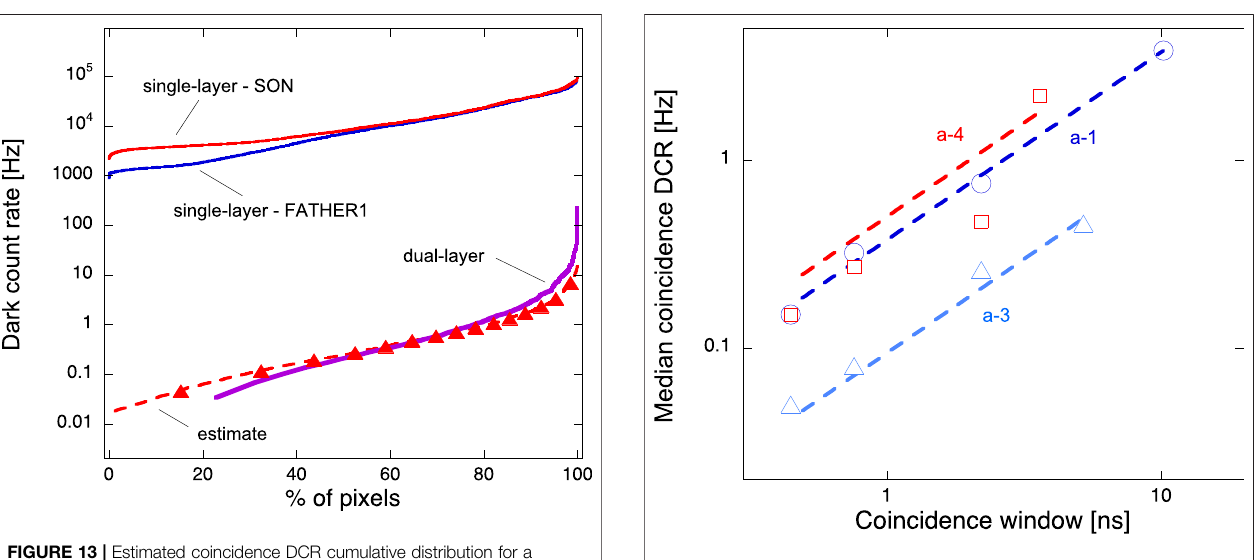
FIGURE 14 | Median value of the coincidence DCR extracted from cumulative curves relevant to a -1, a -3 and a -4 arrays, plotted as a function of the coincidence window width. Linear interpolation of the data is represented by the dashed lines. The coincidence window width is the one obtained from simulation in typical conditions (typical process corner, 25 ° C and 1.8 V bias voltage). Note that both axes are in logarithmic